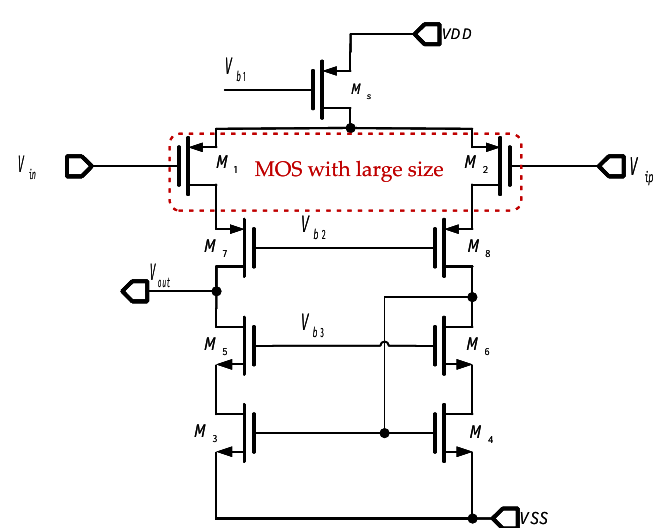
Figure 5. The schematic of telescopic cascade amplifier. When φ 1 is on, the voltages of C 1 and C 2 are reset to zero so that there is no charge on C 1 and C 2 . When φ 1 goes off at t 2 , the input current begins to charge C 1 , v 1 + , and v 1 − starts to rise (fall) or fall (rise) until the next period comes. After φ 2 is off at t 3 , v 2 + , and v 2 − follow the change of v 1 + and v 1 − , respectively. Sample and hold circuit, consisting of a CMOS switch φ 3 and a sample capacitor C 3 , is used to sample v 2 at the end of t 5 and hold the value until the next time when φ 3 is on. The brief waveforms of the node voltage of the TIA are shown in Figure 6